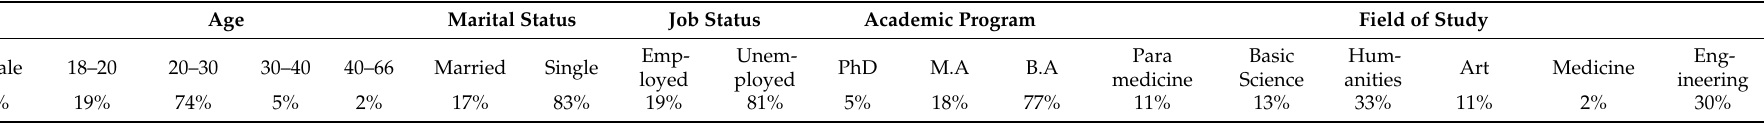
Table 1. Demographic characteristics of